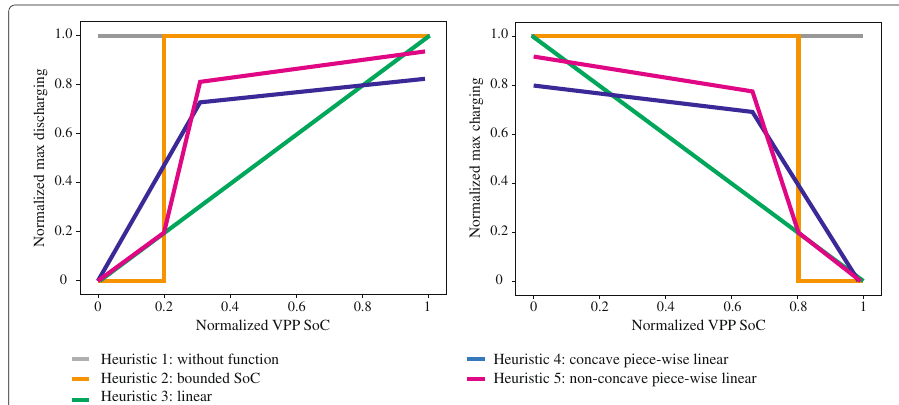
Fig. 3 Candidates for f char / dischar models: The function f char / dischar models the relationship of VPP SoC versus its charging and discharging capabilities (see also Fig. 1). Tested in this paper are the performance of 5 different promising candidates. The first candidate, does not take this relationship into account. The second model bounds the SoC, so that only 20% to 80% of the VPP SoC can be used. The third model uses simply a linear, the fourth a concave and the fifth a non-concave piece-wise linear relationship. The fifth model is most